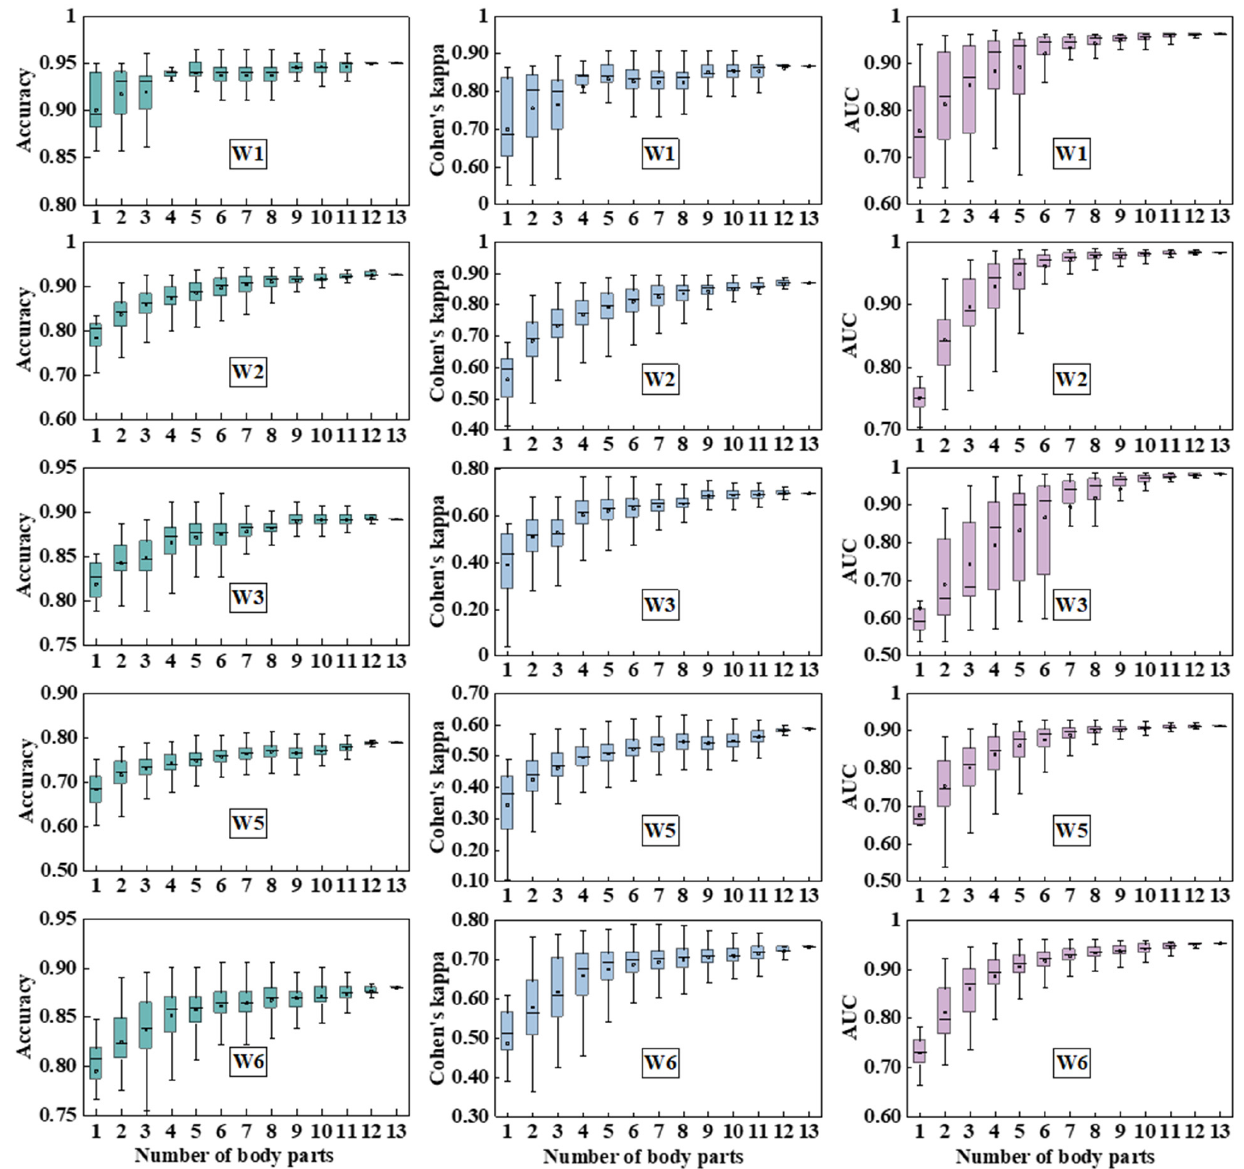
Figure 13. The accuracy, Cohen’s kappa, and AUC for each subject with different numbers of body parts in the combinations.